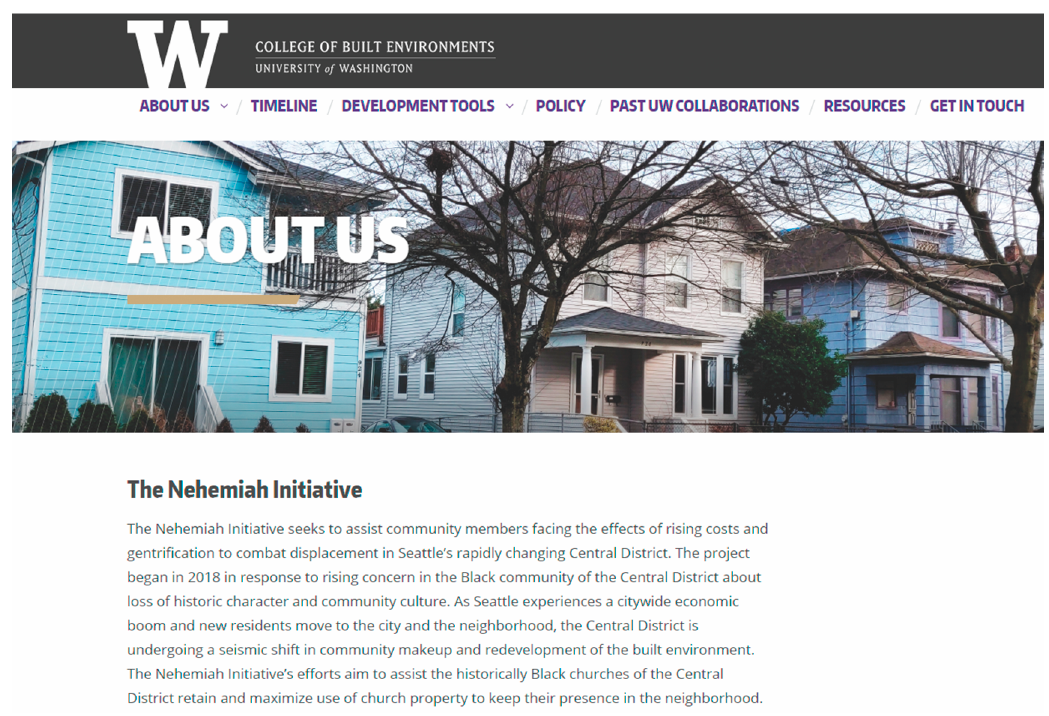
Figure 8. Screenshot of the Nehemiah Initiative website. Source: Spring 2020 Nehemiah Urban Planning Studio.